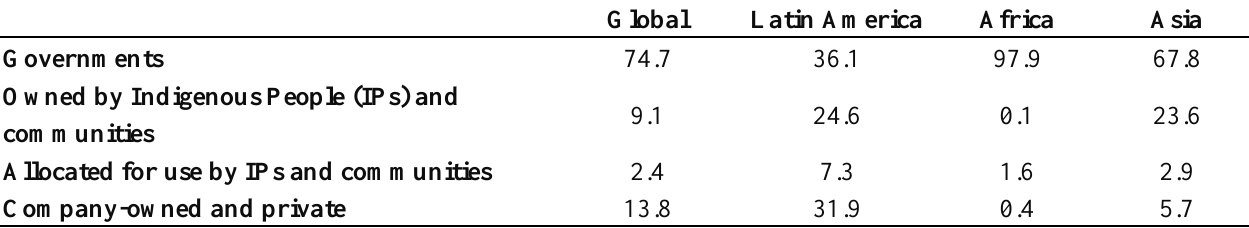
Table 2. Forest tenure by region